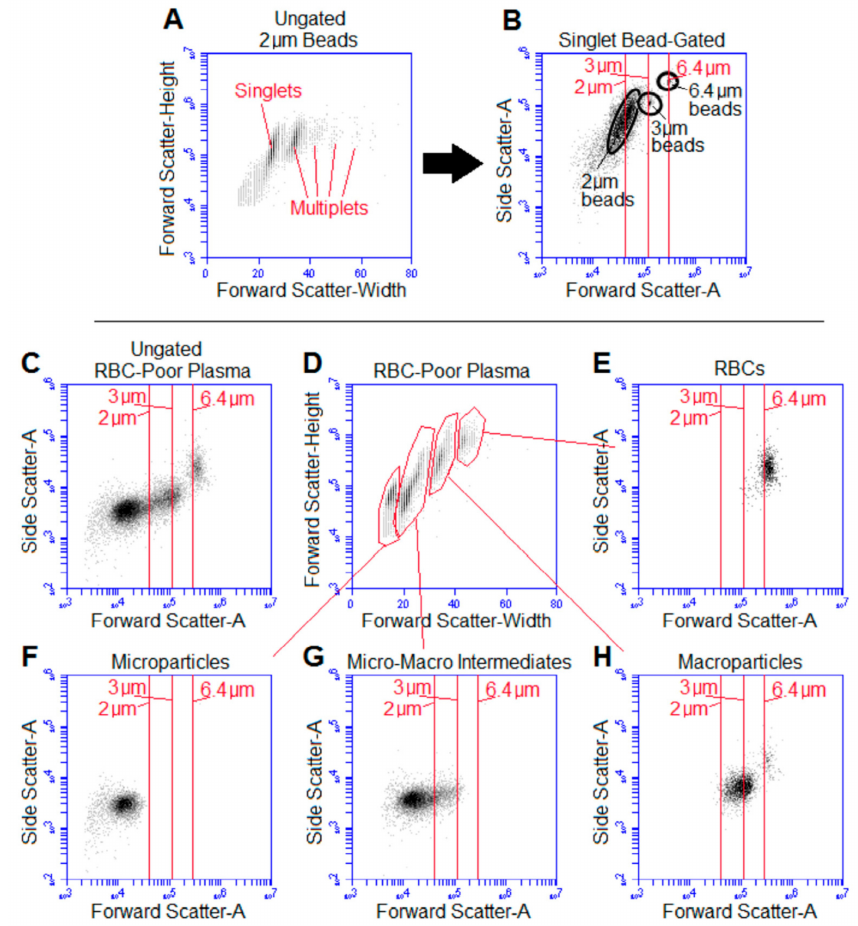
Figure 2. Size determination of cell-to-microparticle intermediate “macroparticles”: ( A ) Example identification of singlets in examining 2 µ m beads using the forward scatter height by width; multiplets have disproportionately large width relative to height. ( B ) Light scatter of singlet beads (highlighted in the black circles) of various sizes was used to estimate the size of RBC macroparticles, with vertical lines corresponding to the forward scatter (FSC) of the singlet bead population. ( C ) Representative ungated RBC-poor supernatant with size windows shown by vertical lines corresponding to bead size based on data from ( B ). ( D ) This supernatant was examined for multiplets based on forward scatter height and width and gated to show ( E ) RBCs, ( F ) microparticles, ( G ) intermediately sized vesicles and possible microparticle doublets, and ( H ) macroparticles. Macroparticles made up 9.4% ± 9.3% of RBC-poor supernatant events smaller in diameter than 6 µ m from units 1–4 days after expiration, and their diameter was 2.78 ± 0.35 µ m based on their forward scatter height relative to that of the beads; n = 15 outdated